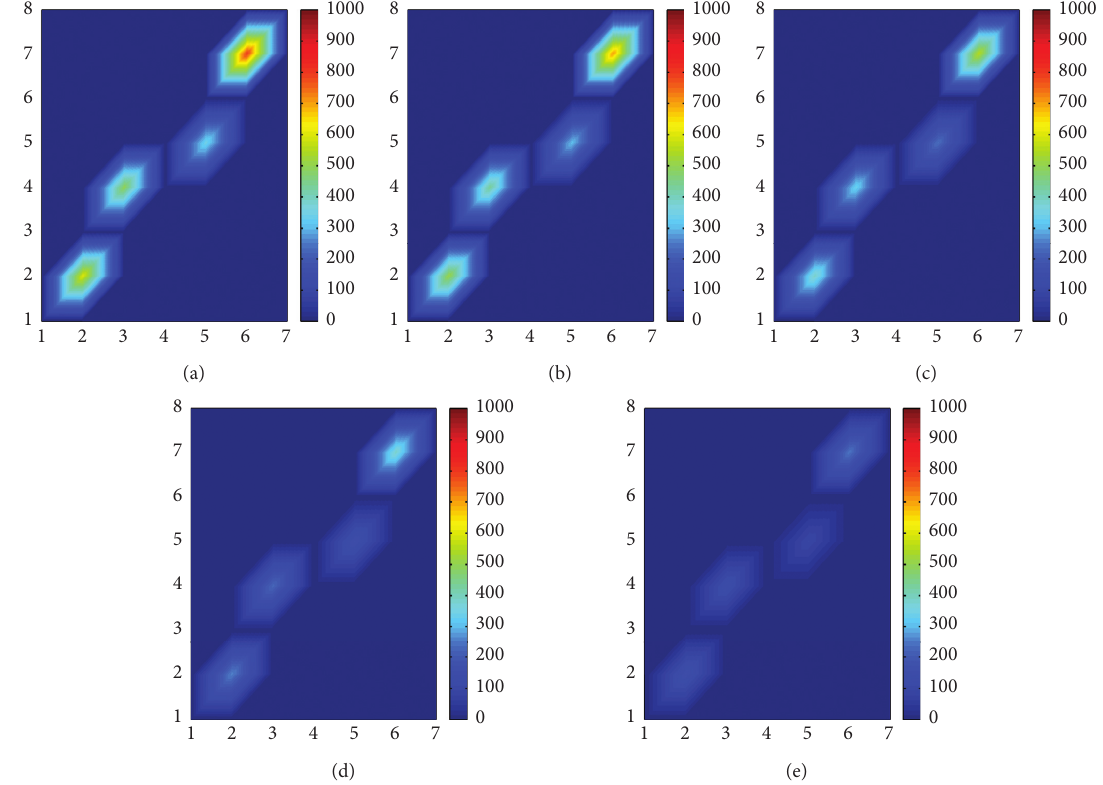
Figure 7: he biomass of prey behavior within Ω with control u C pq . (a) t � 0. (b) t � 50. (c) t � 100. (d) t � 150. (e) t � 200.